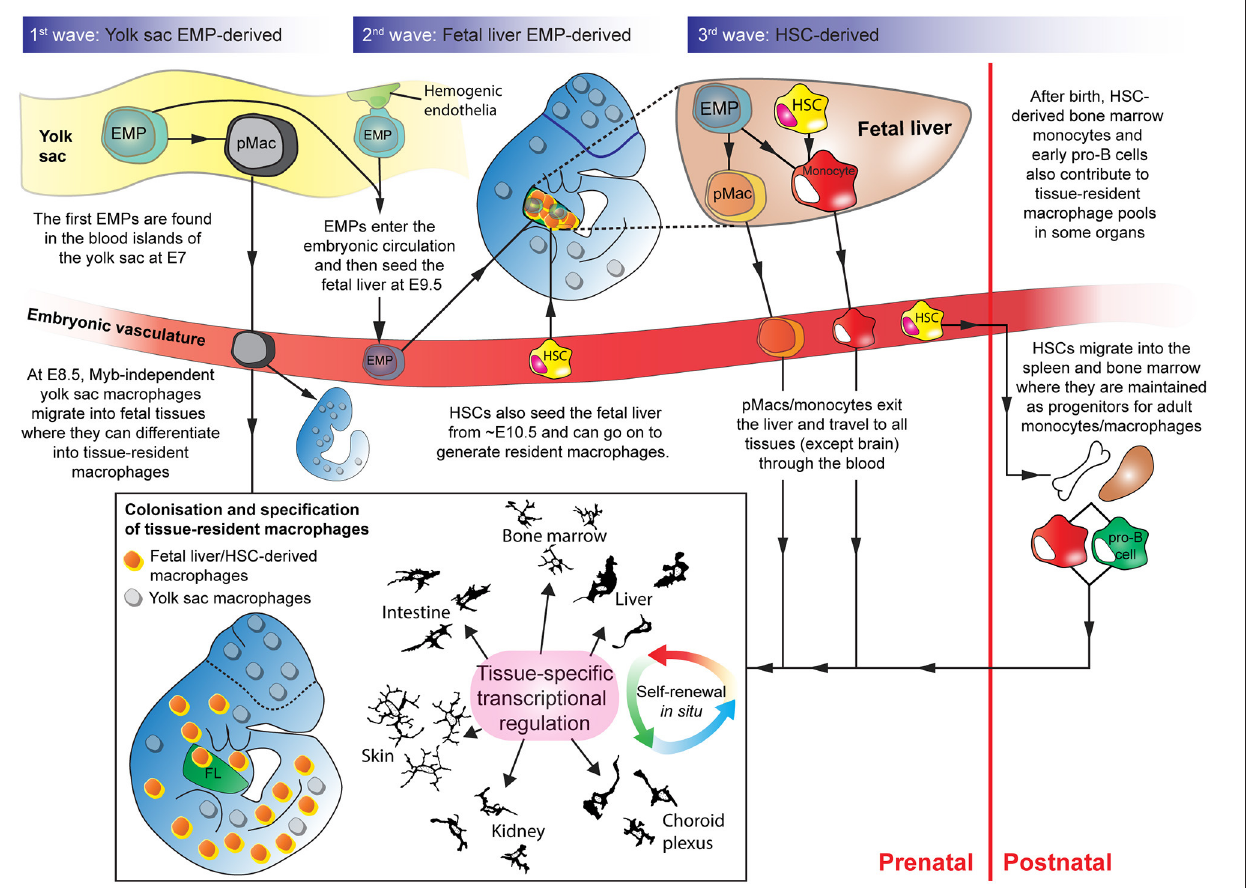
FIGURE 1 | Overlapping waves of macrophage progenitor cells colonize the developing embryo. Wave 1: Yolk sac-derived erythro-myeloid progenitors (EMPs) differentiate into pMacs and migrate through the early embryo. Wave 2: EMPs, derived from hemogenic endothelium in the yolk sac, enter the fetal liver. In the fetal liver, EMPs expand and differentiate into pMacs and/or monocytes. pMacs/monocytes then egress from the fetal liver and travel through the vasculature into developing organs. Wave 3: Haematopoietic stem cells (HSCs) from the aorta-gonad-mesonephros region also enter the fetal liver and contribute to resident macrophage populations. Some HSCs migrate into the bone marrow and the spleen where they are maintained before being released into the bloodstream postnatally as circulating monocytes that can contribute to tissue-resident macrophage populations. Early pro-B cells are also released from the bone marrow in adulthood and can contribute to certain tissue-resident macrophage populations. Depending on where they engraft, macrophage progenitors start to express transcriptional regulators that define their genetic programme in a tissue-specific manner. EMP, erythro-myeloid progenitor; HSC, haematopoietic stem cell; pMac, pre-macrophage; Camera lucida drawings adapted, with permission, from illustrations by Perry ( Gordon et al.,